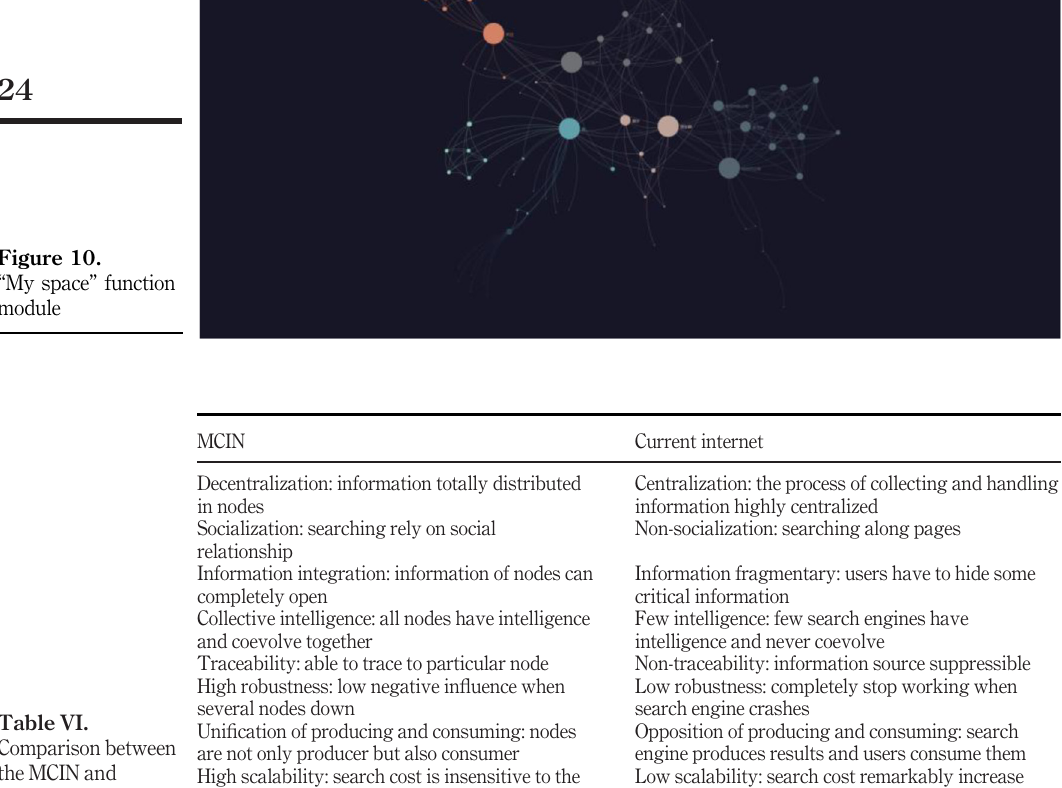
Table VI. Comparison between the MCIN and current